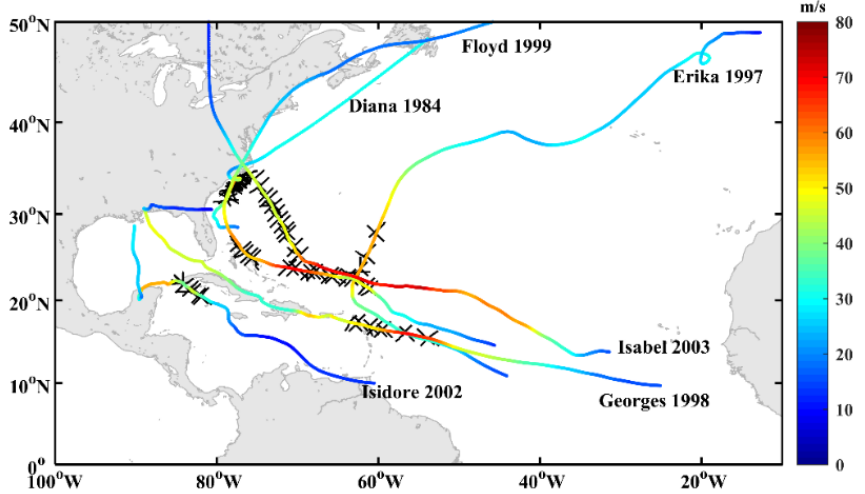
Figure 3. Geolocations of 328 radial legs for six hurricanes with respect to the Best Track estimates. The black lines denote radial legs measured by multiple aircraft missions, whereas the color bar (unit: m/s) denotes Hurricane intensity from the Best Track data.